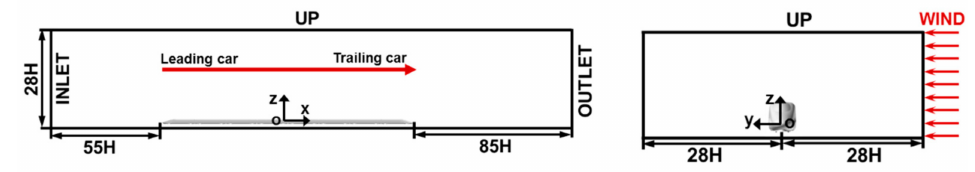
Figure 7. Computational domain.